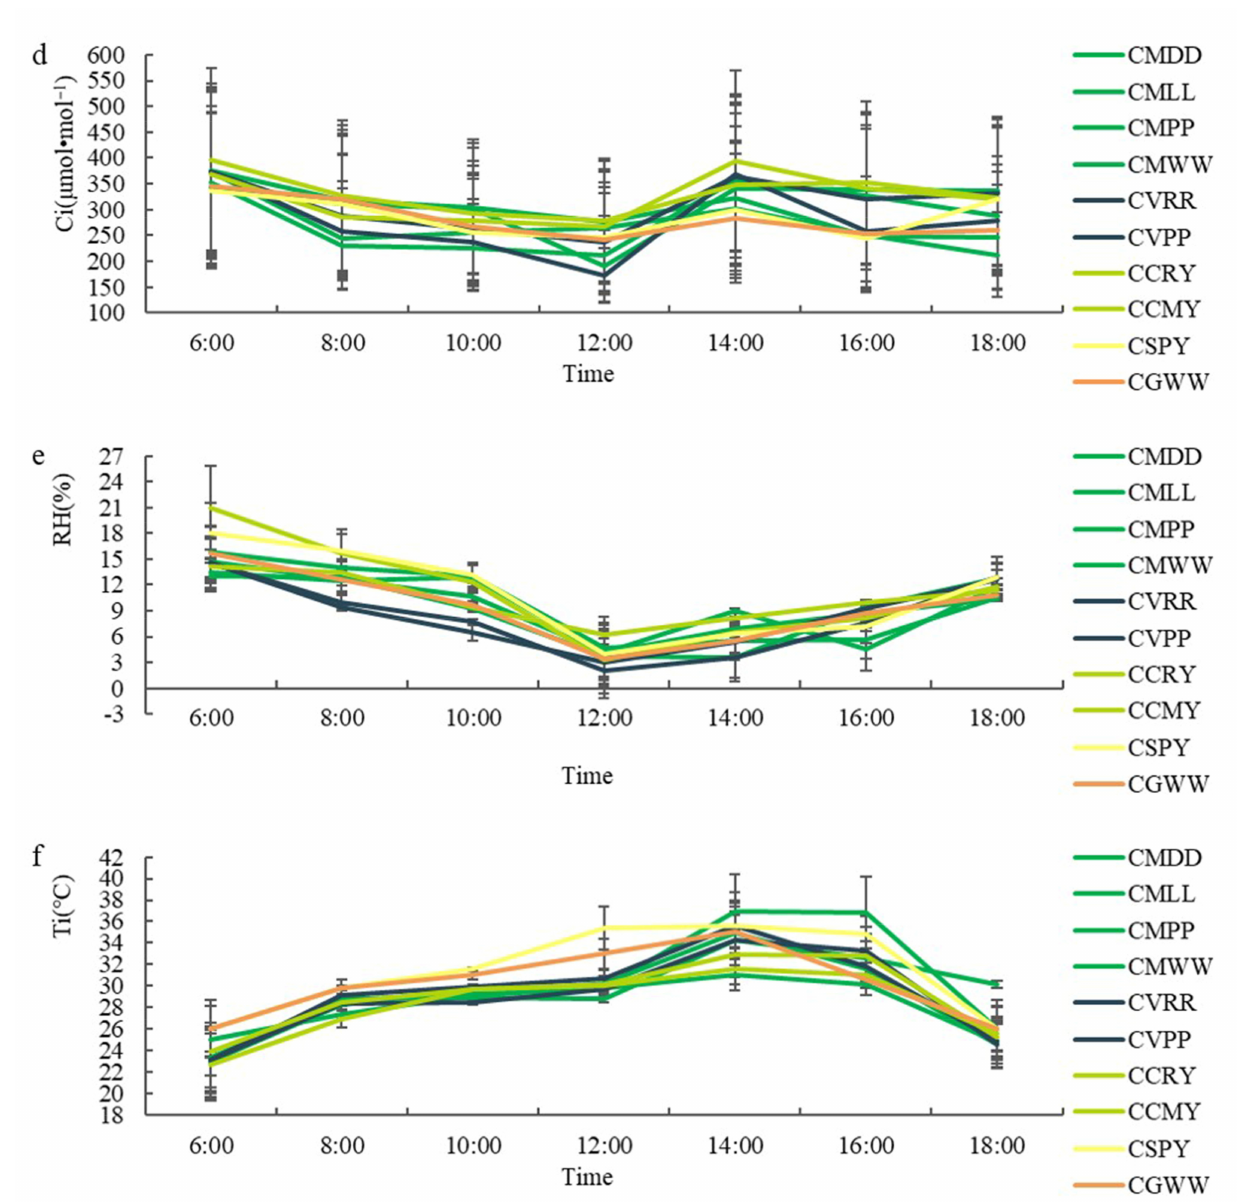
Figure 3. Photosynthetic characteristics of 10 Cypripedium samples. ( a ) Net photosynthetic rate of samples (Pn). ( b ) Transpiration rate of samples (E). ( c ) Stomatal conductance of samples (Gs). ( d ) Intercellular CO 2 concentration of samples (Ci). ( e ) Relative humidity of samples (Rh). ( f ) Leaf temperature of samples